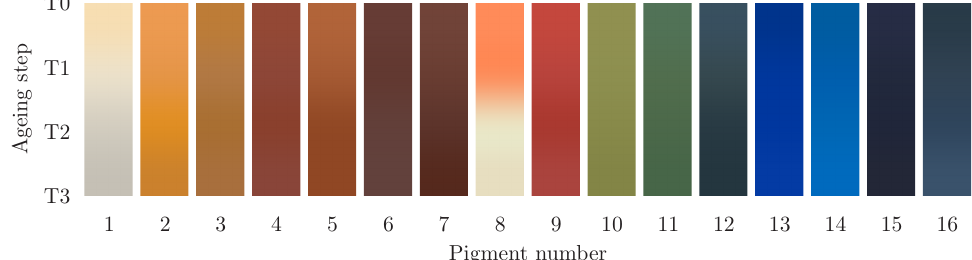
Figure 5. Color degradation after three aging steps for the fundamental pigments of Section